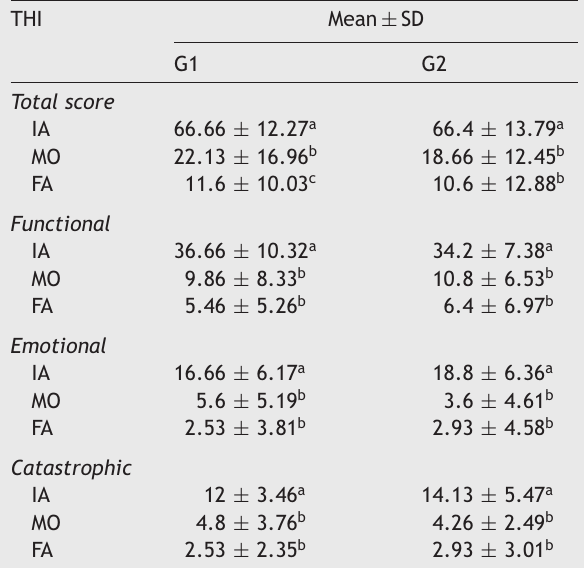
Values of mean and SD of the answers obtained for the THI --- total score, functional, emotional and catastrophic categories in the three stages of